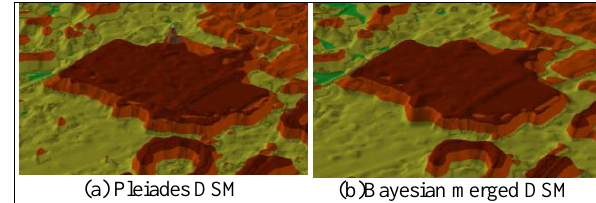
Figure 7. 3D view showing the effect of merging over a flat surfaced structure.